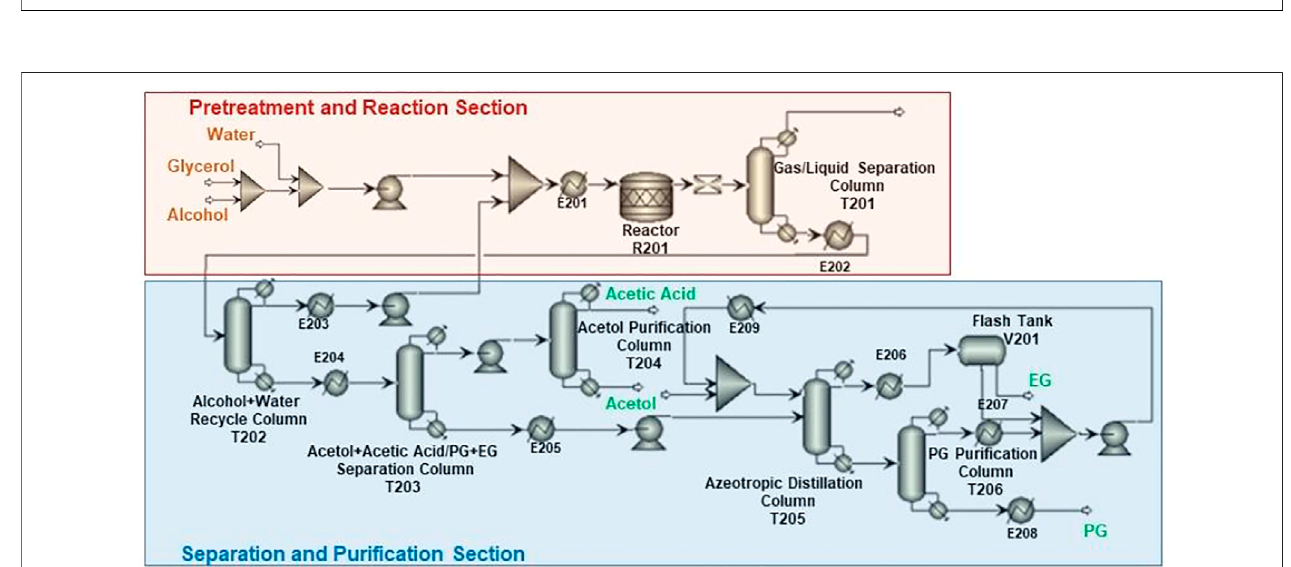
FIGURE 3 | Process scheme for CTH of glycerol.